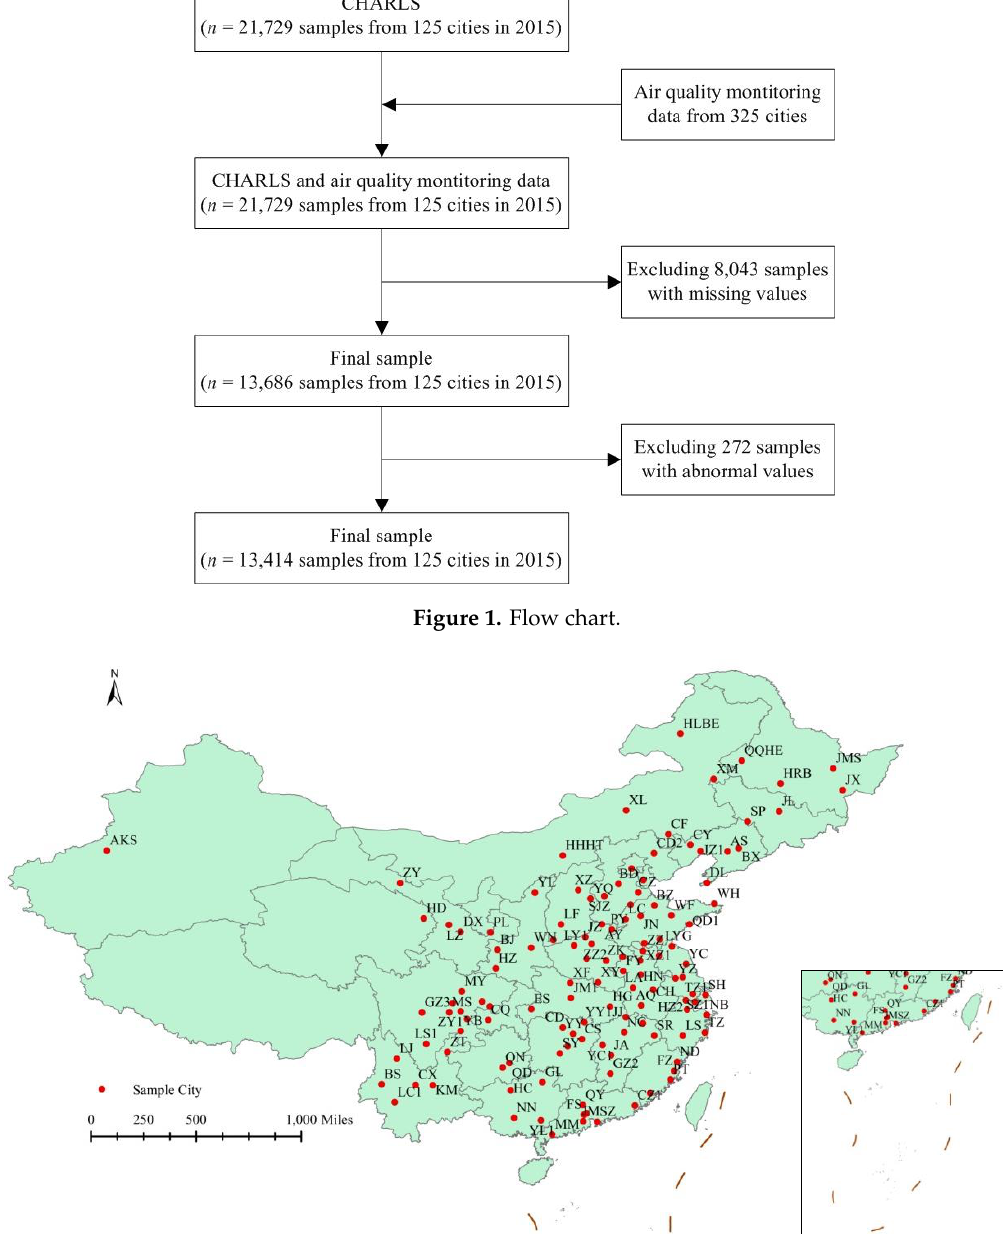
Figure 2. The geographical distribution of sample cities.